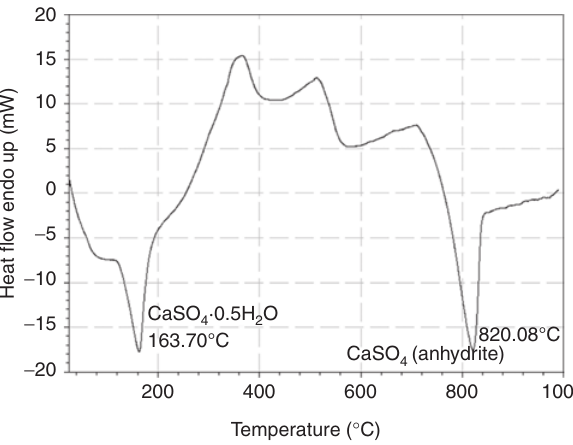
Figure 2: TGA measurement of the dried calcium sulfate dihydrate as prepared from the chemical reaction between duck eggshell and sulfuric acid measured in the range of 25–1000 °